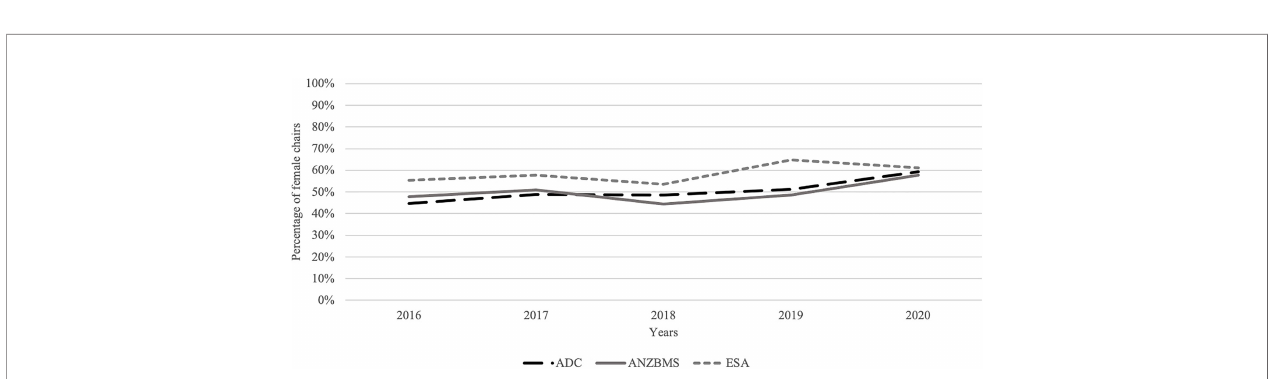
FIGURE 1 | Proportion of conference presentation time by gender and type of session. ANZBMS, Australian and New Zealand Bone and Mineral Society; ESA, Endocrine Society of Australia.